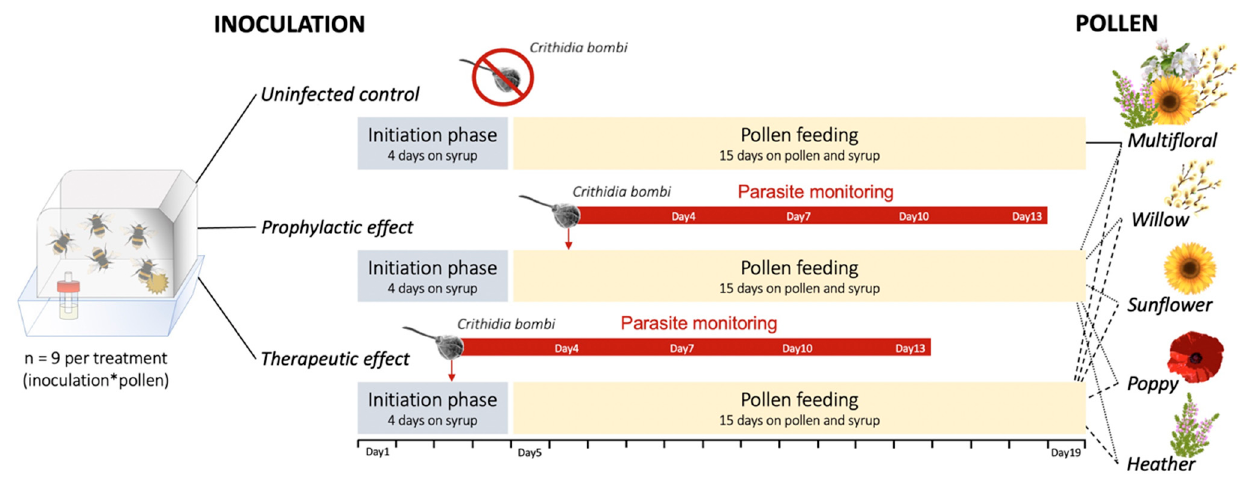
Figure 1. Experimental design used for testing prophylactic and therapeutic effects of five different pollen diets. The experiment timeline including parasite inoculation (red arrow) and monitoring is presented. Uninfected microcolonies fed multifloral pollen diet served as control during the experiment.